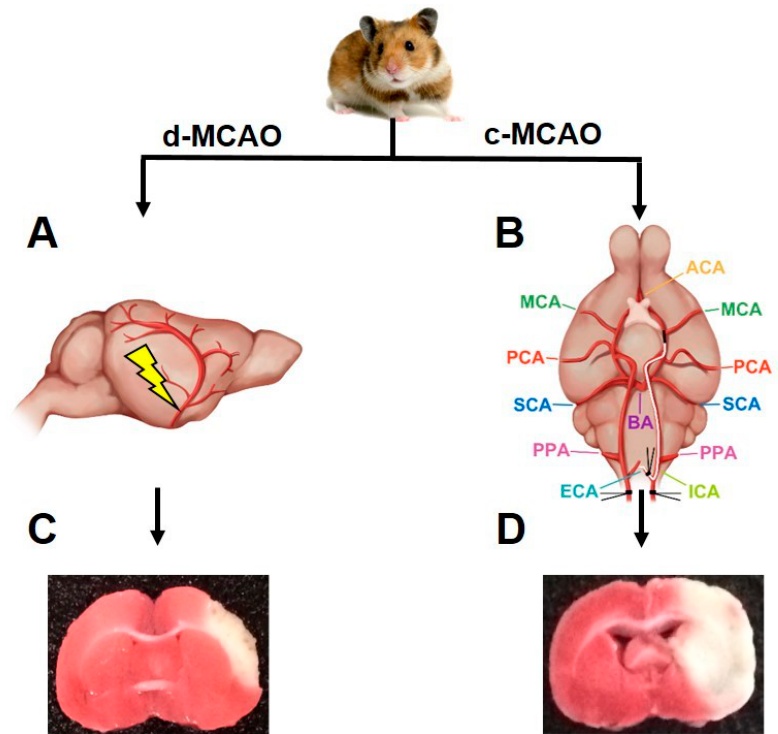
Figure 1. Representative diagram of cerebral ischemic hamster models using distal middle cerebral artery occlusion (d-MCAO) and contralateral middle cerebral artery occlusion (c-MCAO). ( A ) Model representing d-MCAO, in which blood flow is blocked by electrocoagulating the distal middle cerebral artery. ( B ) Model representing c-MCAO, in which a silicon-coated intraluminal suture occludes the origin of the MCA. The right external carotid artery (ECA) is ligated and cauterized to a stump, where the suture goes through into the artery from internal carotid artery (ICA) to MCA, simultaneous ligation of the contralateral CCA is performed for 40 min. ACA, anterior cerebral artery; PCA, posterior cerebral artery; SCA, superior cerebellar artery; BA, basilar artery; PPA, pterygopalatine artery. ( C , D ) 2, 3, 5-triphenyltetrazolium chloride (TTC) staining; white area indicates the infarct and red area is the normal tissue.